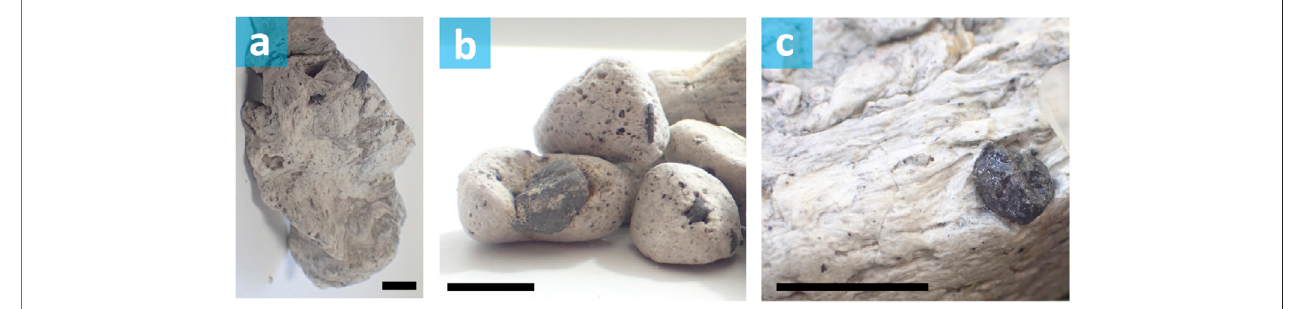
FIGURE 2 | Photographs of embedded rock fragments in the Havre 2012 pumice. (A – C) Representative photographs of embedded rock fragments within the 2012 pumice raft. Note that the black scale bar in each panel is equal to 1